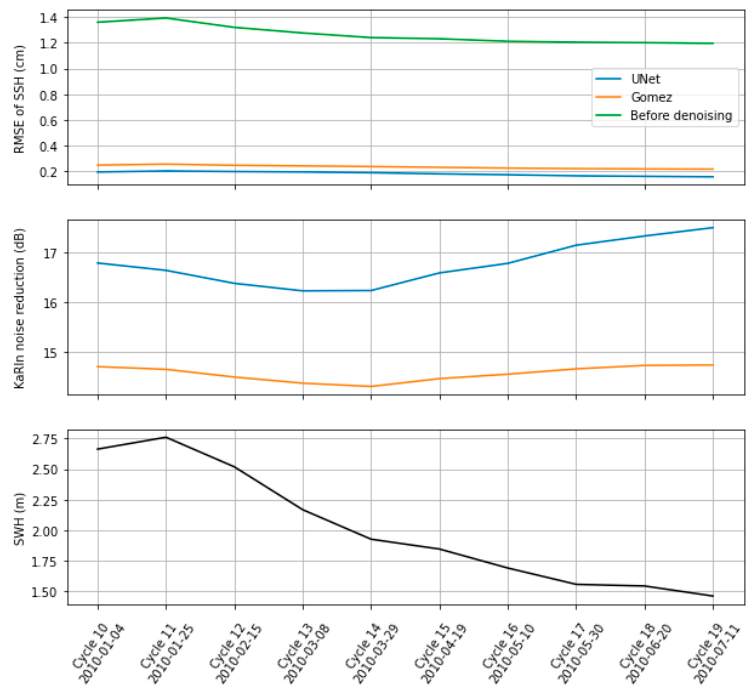
Figure 9. SWH, RMSE of SSH and KaRIn noise reduction as function of the cycle. The dates correspond to the beginning of each cycle. The results of the U-Net model are in blue and the Gomez filter in orange.